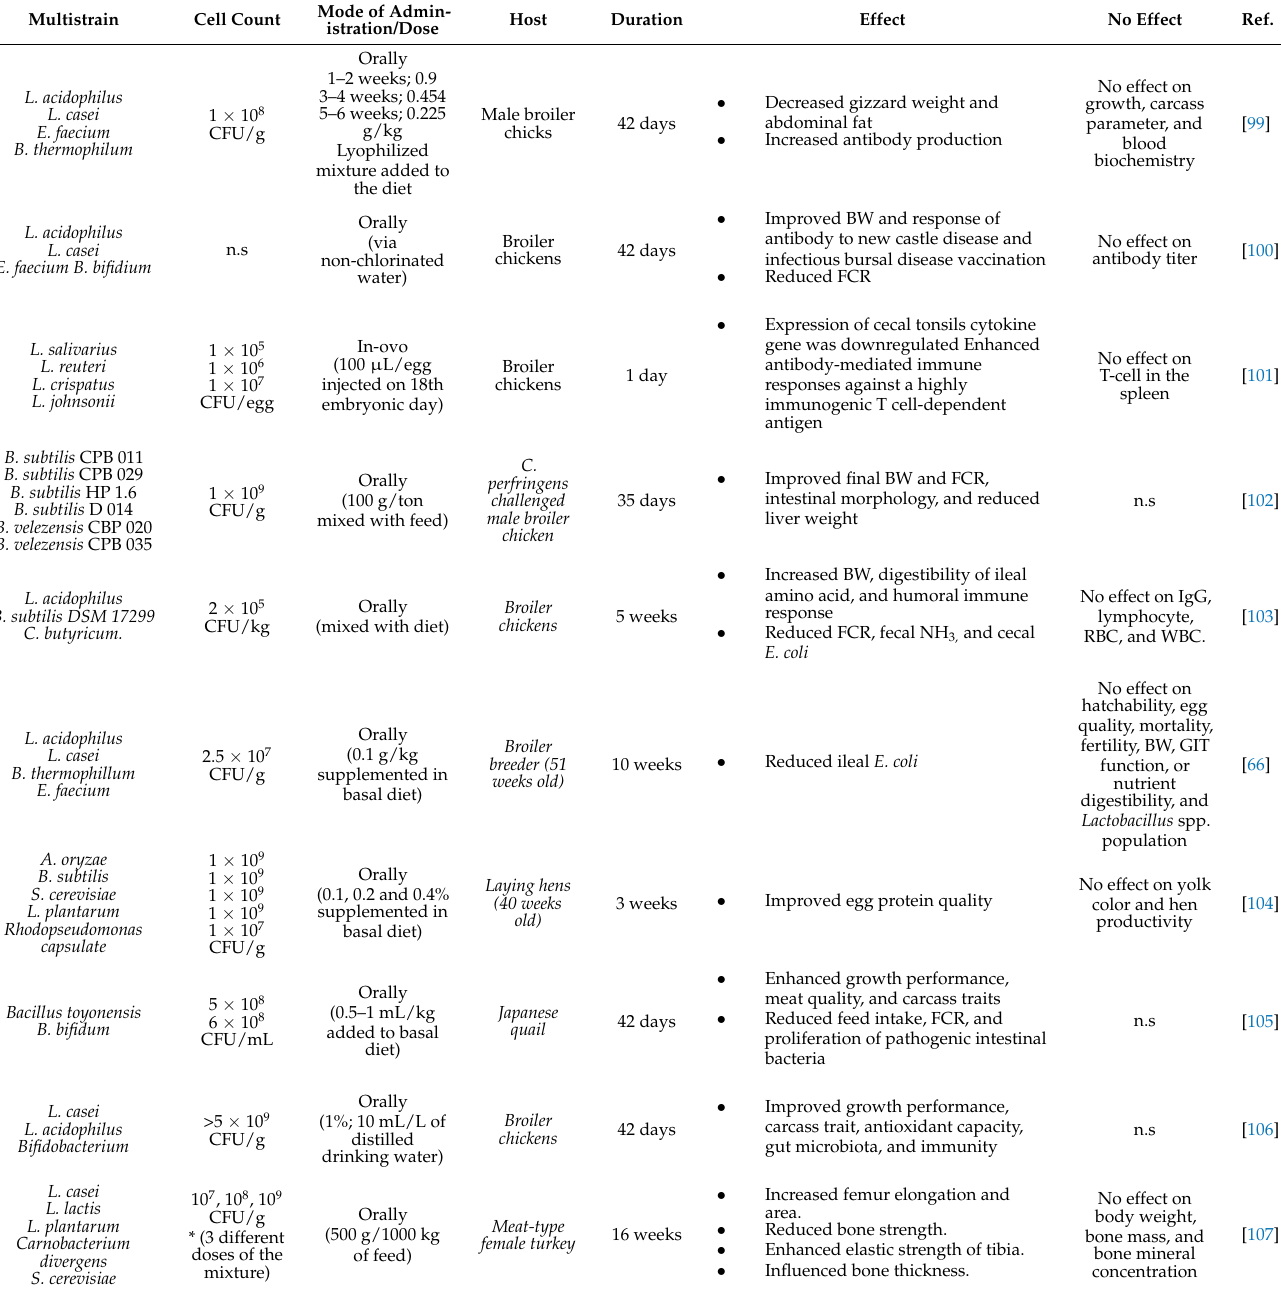
Table 2. Various combinations of multistrain probiotics and their effect on poultry